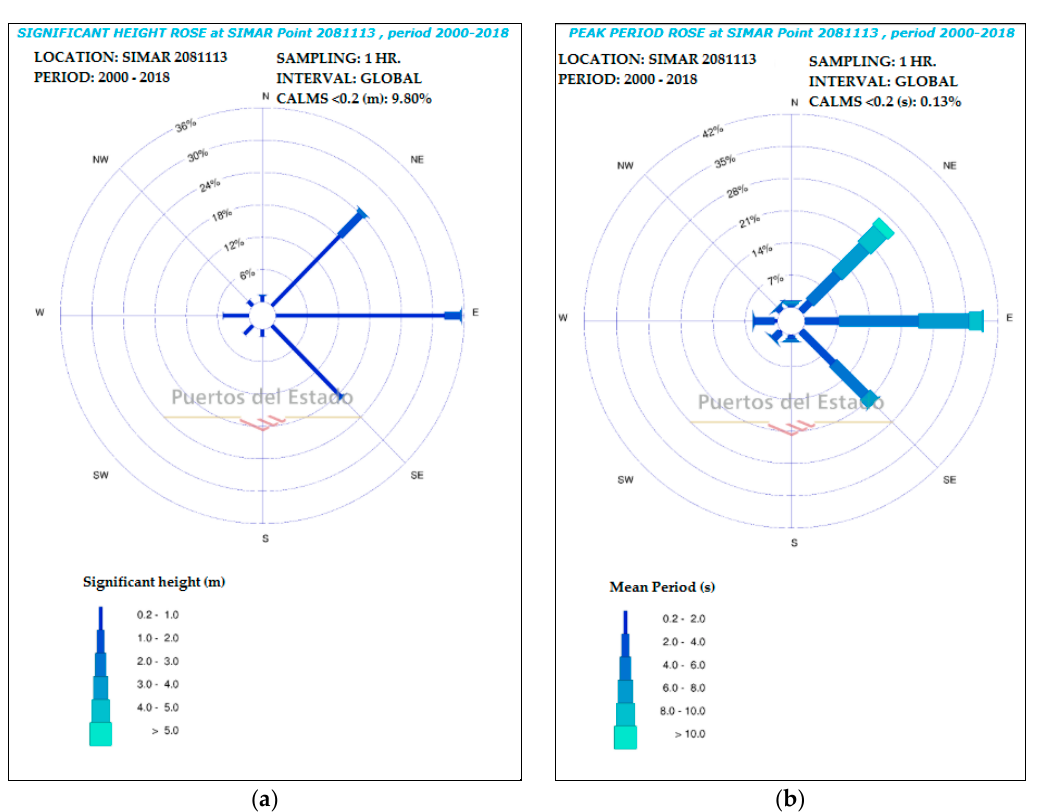
Figure 11. ( a ) Significant height rose for the Port of Valencia area. ( b ) Mean period rose for the Port of Valencia area. Source: www.puertos.es. Valencia area. Source: